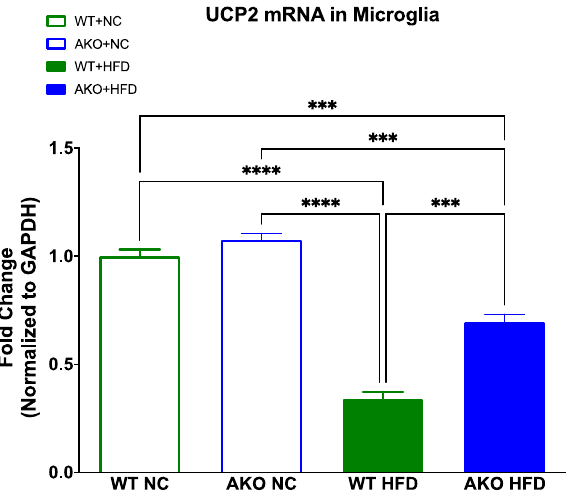
Figure 7. Loss of FABP4 alleviates decrease in UCP2 caused by HFD in microglia. WT mice fed NC, WT mice fed HFD, AKO mice fed NC, and AKO mice fed HFD (n = 3) microglia isolated from brain tissue assayed for UCP2 mRNA expression using qRT-PCR. HFD-fed WT mice had decreased UCP2 compared to NC-fed mice ( p < 0.0001; Figure 7). HFD-fed AKO mice have increased UCP2 compared to HFD-fed WT mice ( p < 0.001; Figure 7). Data analyzed via one-way ANOVA and Tukey’s